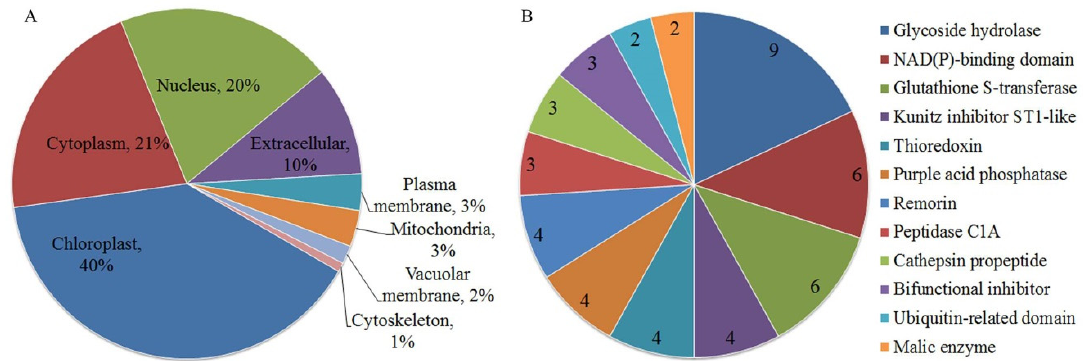
Figure 3. Analysis results of subcellular localization and protein domain. Note ( A ) subcellular localization analysis was derived from TargetP1.1 prediction; ( B ) protein domain analysis.